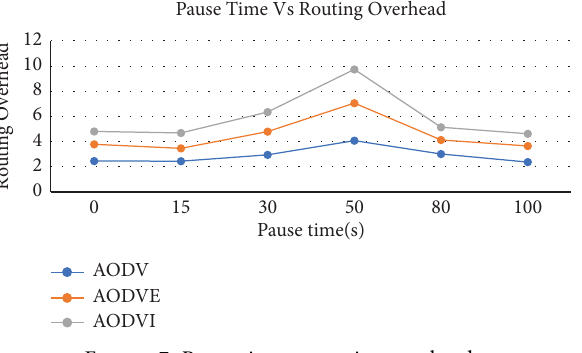
Figure 7: Pause time vs routing overhead.